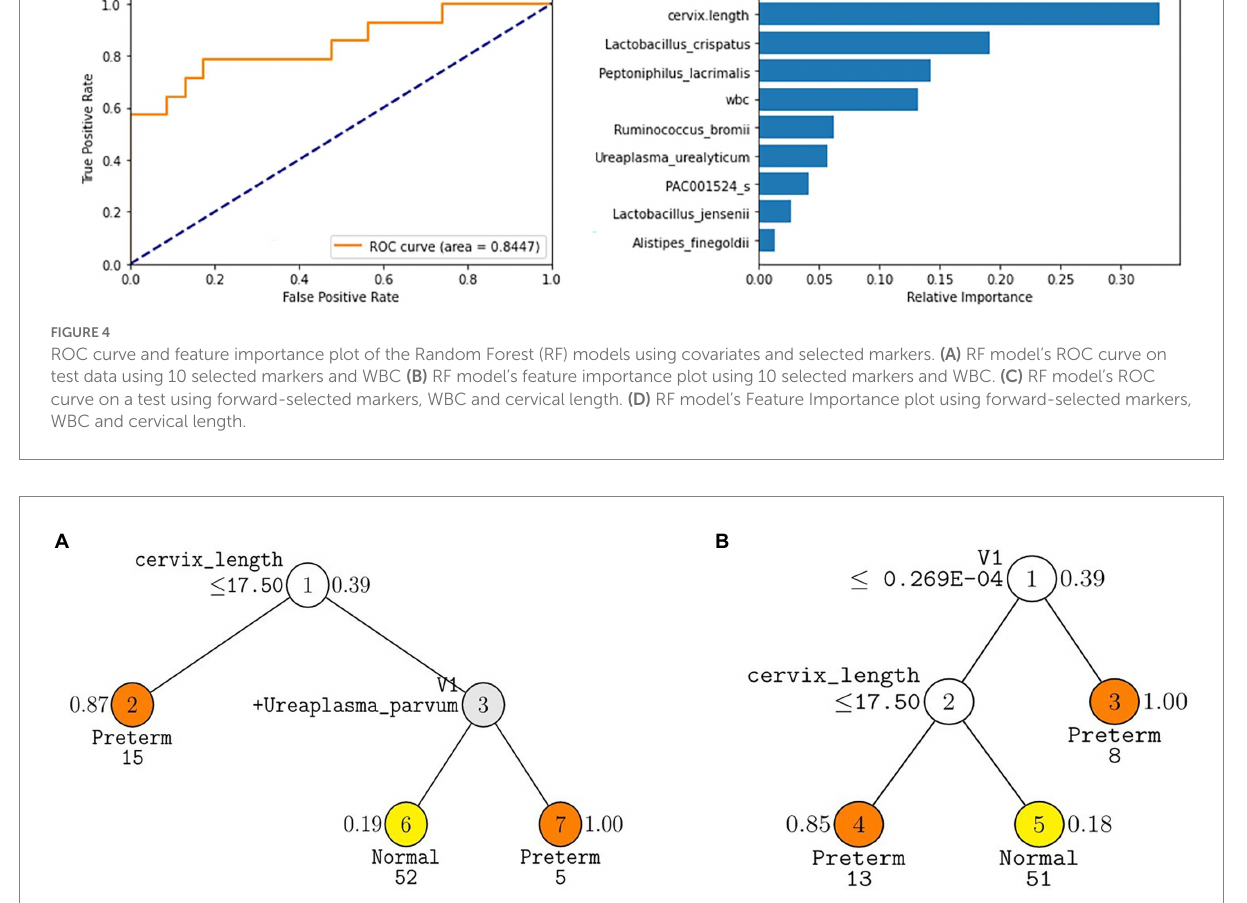
FIGURE 5 Decision trees made from GUIDE algorithm using covariates, cervix length and WBC with (A) ten pre-selected markers and (B) seven markers forward selected from the total markers. GUIDE v.38.0 classification tree for predicting Y using estimated priors and unit misclassification costs. Tree constructed with 109 observations. Pruning parameter α was 0.02 for A and 0.03 for B . At each split, an observation goes to the left branch if and only if the condition is satisfied. Predicted classes and sample sizes printed below terminal nodes; class sample proportion for Y = Preterm beside nodes. In (A) , V1 stands for Prevotella timonensis . In (B) V1 stands for Peptoniphilus